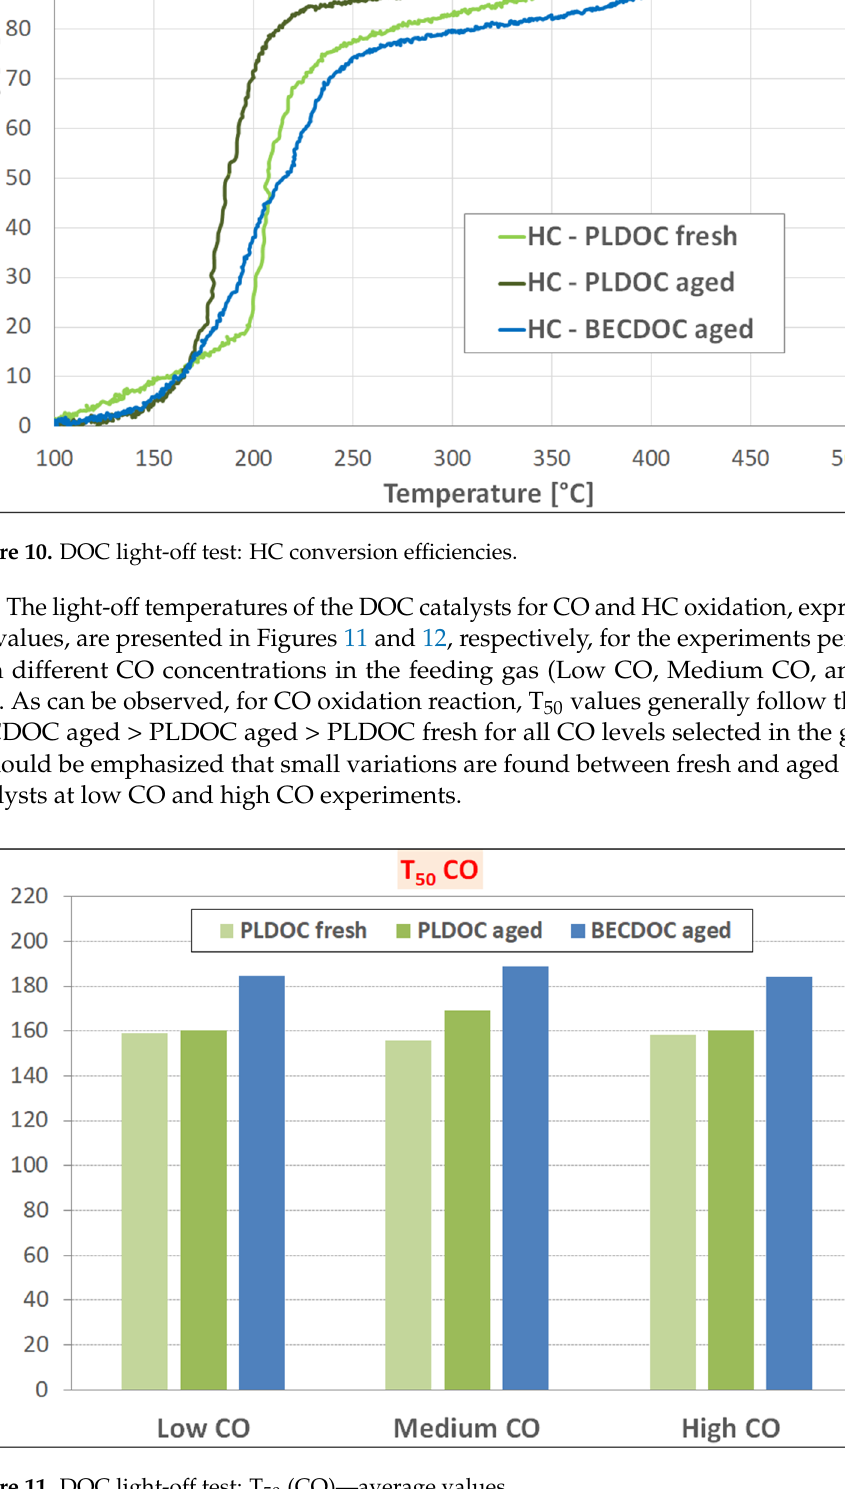
Figure 9. DOC light-off test: CO conversion efficiencies.